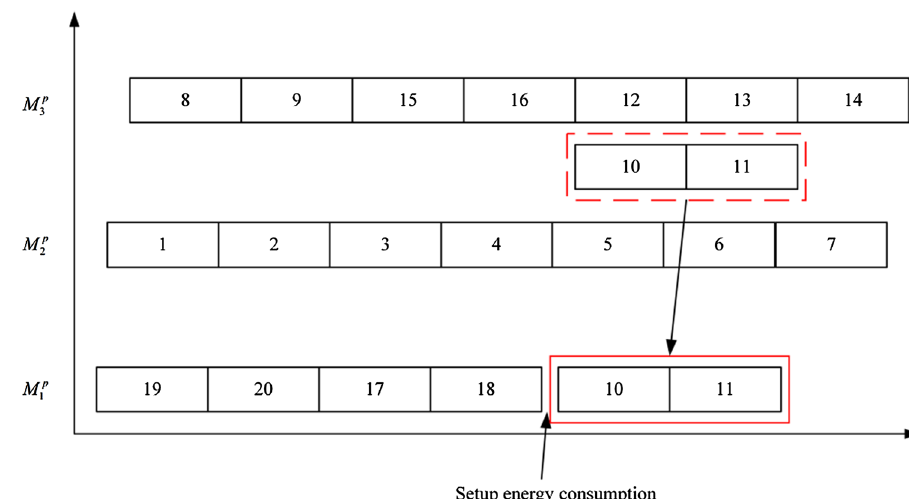
Fig. 5 The adjusted job process- ing sequence of stage one